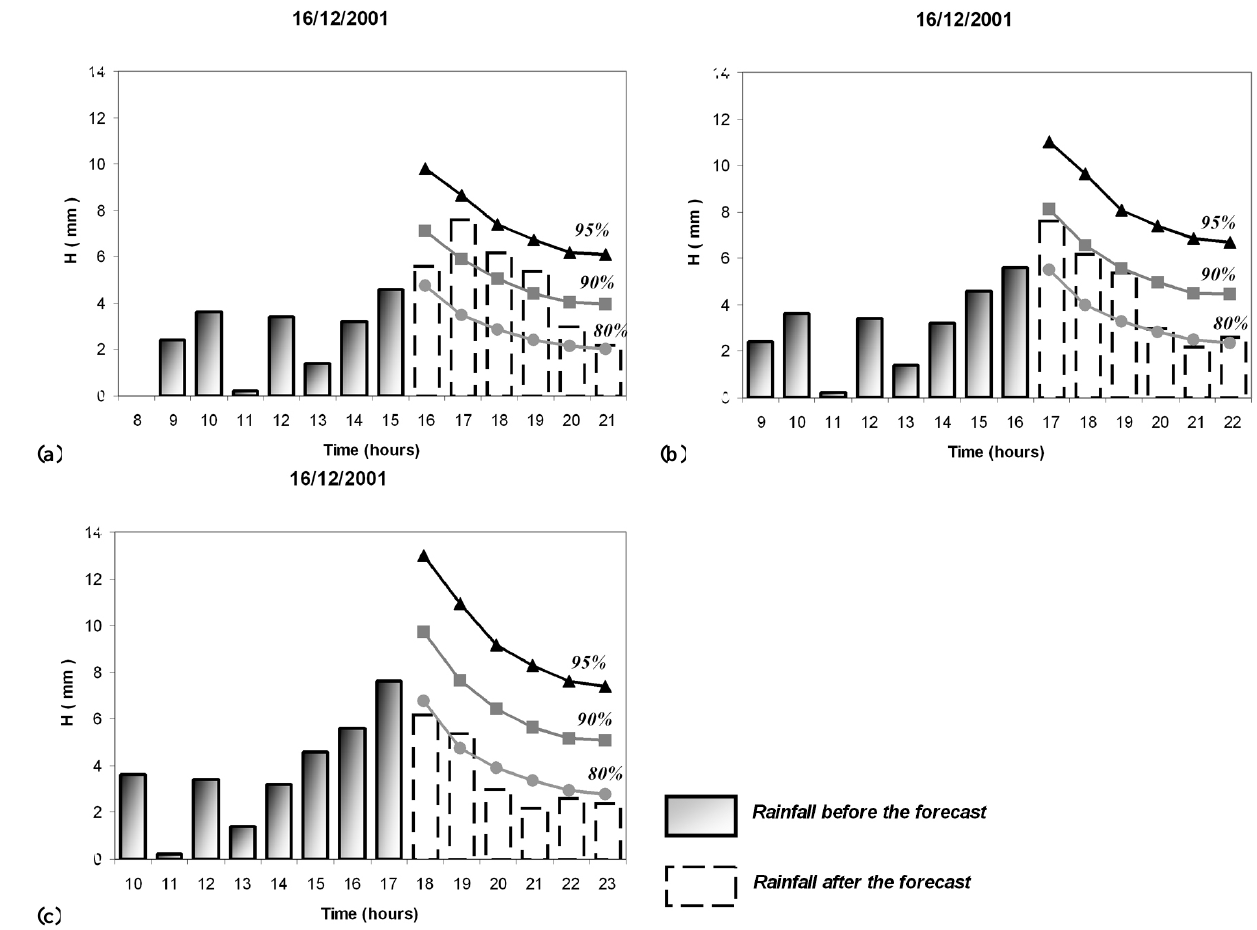
Fig. 8. Application of PRAISE Model relative to 16 December 2001, for the Catanzaro raingauge, starting from (a) 15:00 LT; (b) 16:00 LT; (c) 17:00